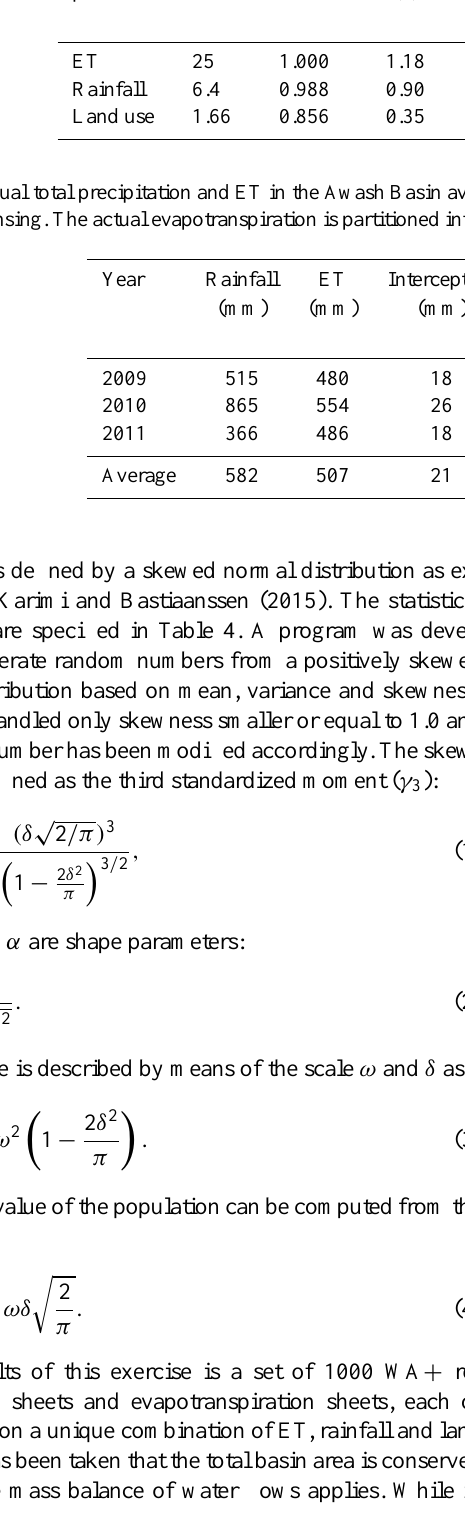
Table 4. Statistics of the probability density function of variation for each remote sensing input parameter into WA + . Remote Shape Shape Skewness Scale Variance Standard Location Mean sensing α (cid:49) γ ω (%) deviation ζ (%) parameter (–) error ET